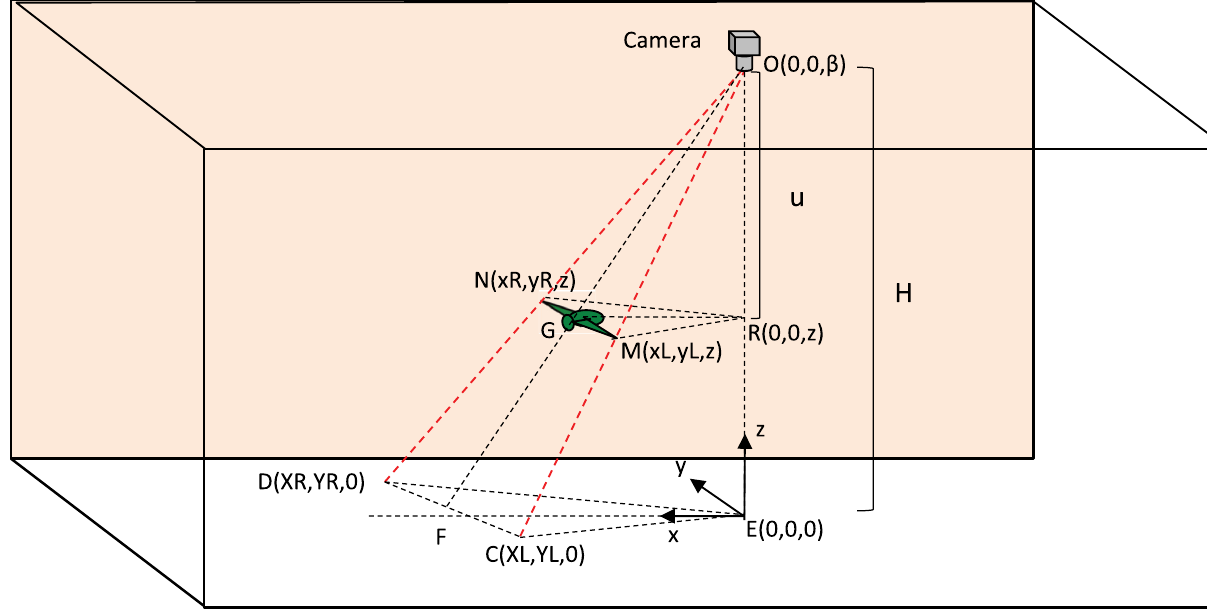
Fig 3. Experimental chamber. Schematic view of experimental chamber, showing the variables used for computing the instantaneous 3D position of the bird and its wingtips. E is the point on the floor that is directly beneath the camera, i.e., the point where the camera’s optic axis intersects the floor.